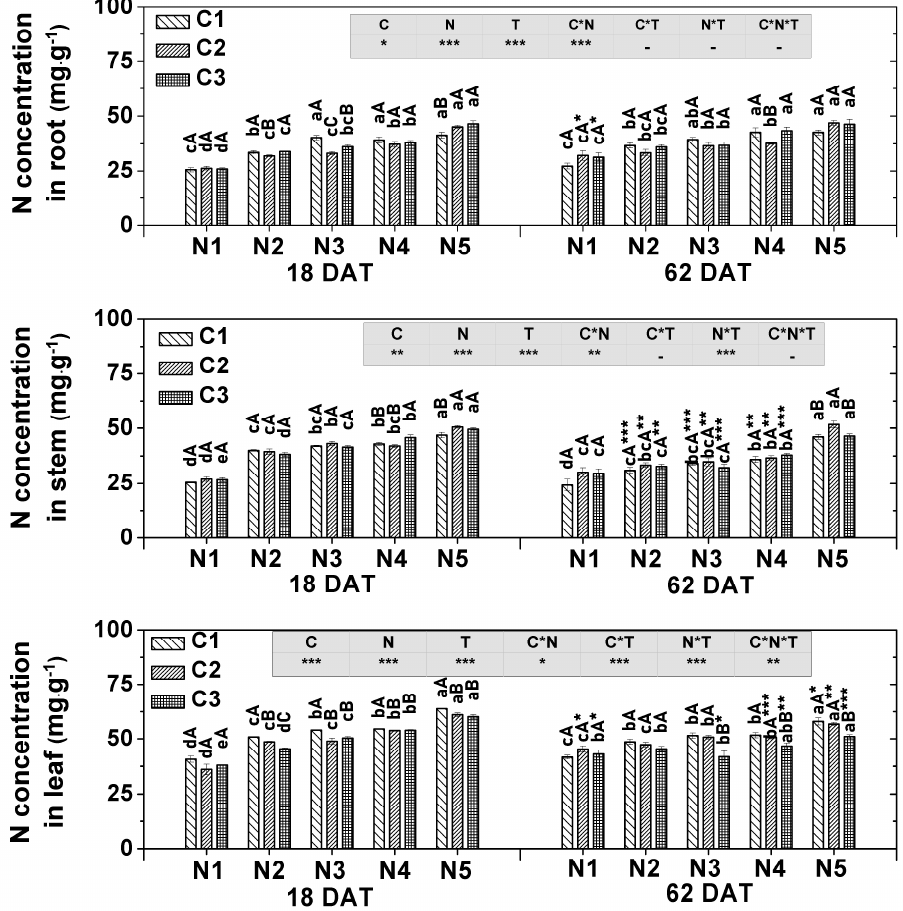
Figure 2. Nitrogen concentrations in di ff erent tissues of cucumber plants grown under di ff erent N and [CO 2 ] levels at two growth stages ( n = 6). Bars represent standard errors. CO 2 levels: C1, C2, and C3: 400, 625, and 1200 µ mol mol − 1 . N levels: N1, N2, N3, N4, and N5: 2, 4, 7, 14, and 21 mmol L − 1 .